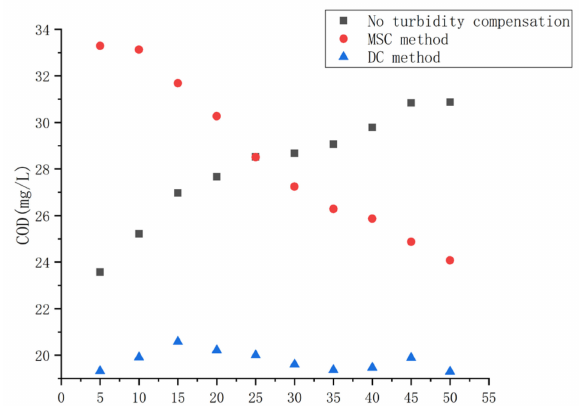
Figure17. Thecomparisonamongnoturbiditycompensation,